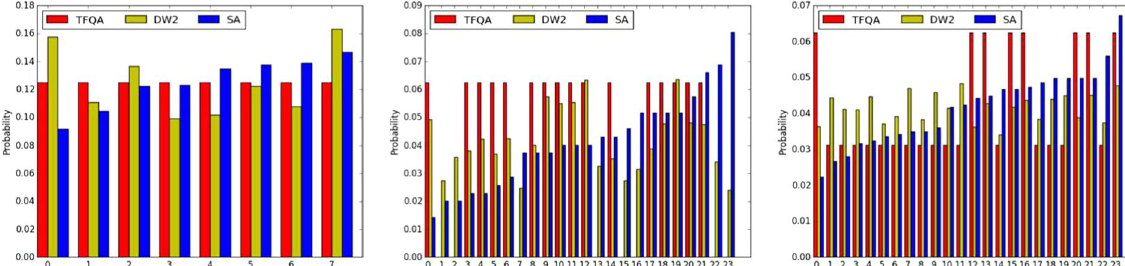
Figure 4. Three representative GSDs for simulated annealing (SA - blue), ideal transverse-field quantum annealer (TFQA - red) and the D-Wave Two experimental processor (DW2 - yellow). In the left instance, probabilities for obtaining the various ground-states predict that all solutions are about equally likely. In the middle instance, we observe that those ground-states that our analytic TFQA predicts should appear more often, and do indeed appear more often in the experimental DW2 data. In the right instance, there is no clear relationship between the various algorithms.